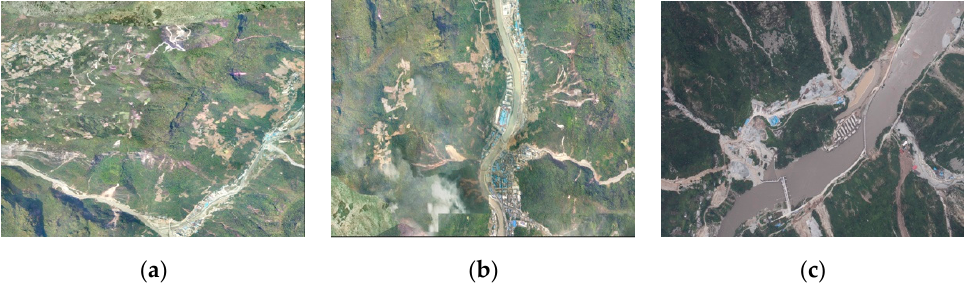
Figure 9. The preprocessed UAV imageries. ( a ) Experimental image 1; ( b ) Experimental image 2; and, ( c ) Experimental image 3.